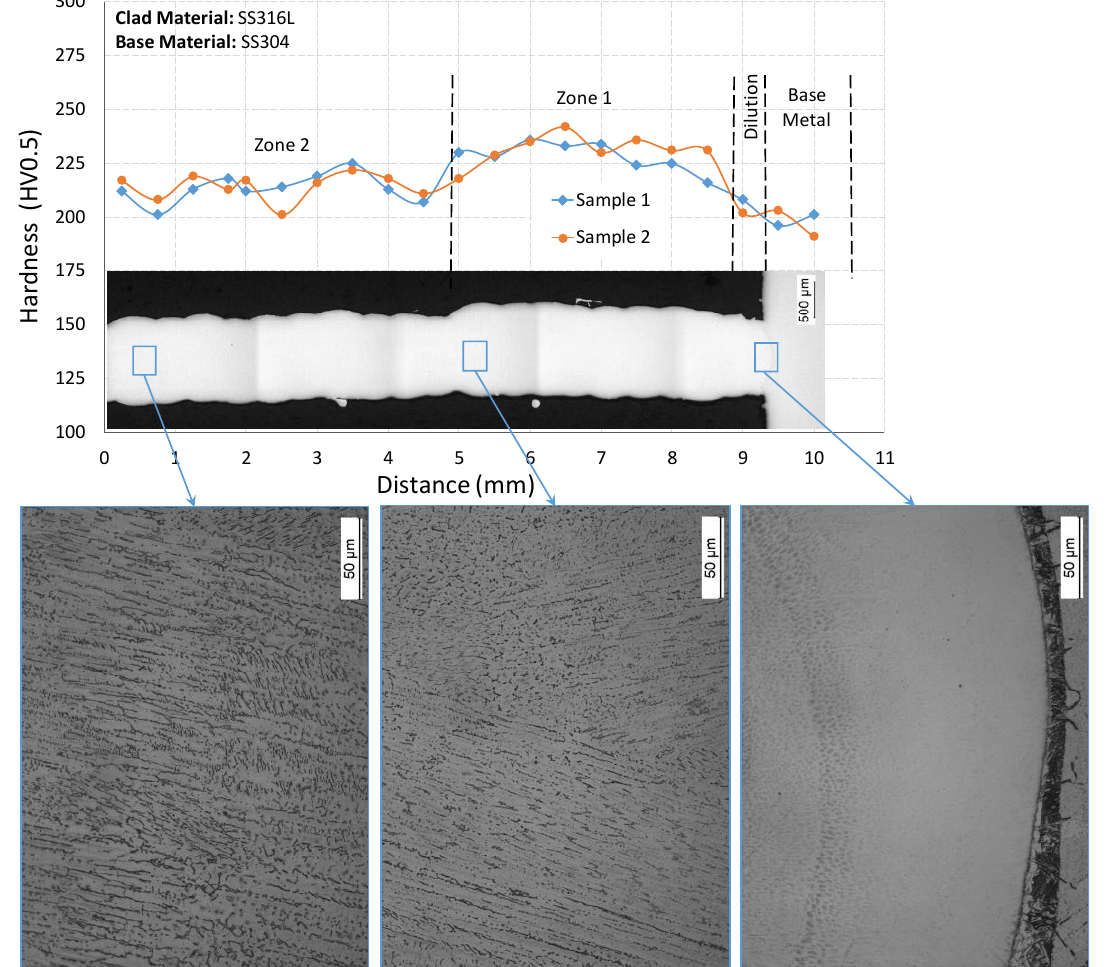
Figure 14. Microhardness profile on the walls made of SS316L (samples 1 and 2) and the microstructure in each area of the walls.